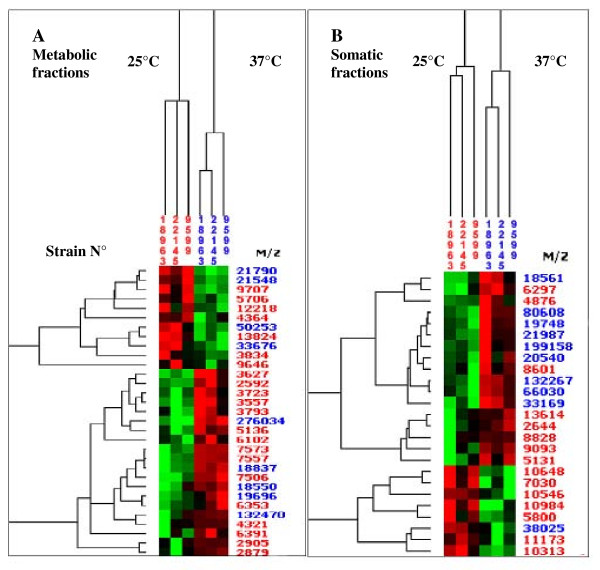
Proteomic analysis of the temperature effects. The hierarchical clustering obtained on CM10 ProteinChips® with metabolic extracts (A) and somatic extracts (B) with the three wild-type A. fumigatus strains (IHEM 18963, IHEM 22145, IHEM 9599). The three extracts, one for each strain, obtained at 25°C (in red) and at 37°C (in blue) are indicated on the top of the figure. Values on the right indicate the molecular mass of protein differentially expressed according to the laser intensities used (in red 2000 nanoJoule (nJ) and in blue 4000 nJ). Two clusters were observed according to growth temperatures with the metabolic and the somatic extracts. Higher number of proteins was up regulated at 37°C than at 25°C in both fractions. In the dendrograms shown, the red, black or green colour indicates that the relative intensity of the protein concentration is respectively higher, intermediate or lower than the mean value.